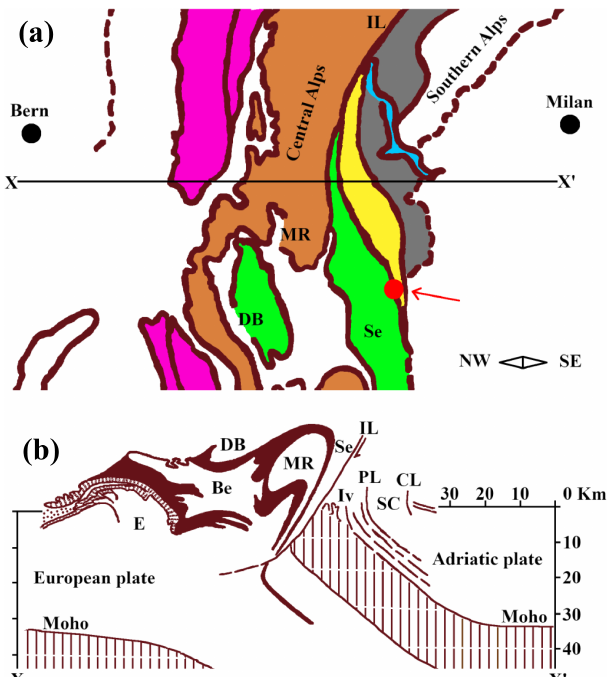
Figure 1. (a) Tectonic setting of the sample locality, digitally re- drawn and modified after Zingg (1990). The X – X (cid:48) line represents the profile section shown in panel (b) . In panel (a) , the purple area represents the external massifs, the light brown areas are the Pen- ninic basement, the green area shows the Austroalpine basement, and the orange area is the South Alpine basement. The yellow area is the Ivrea zone, and the light blue area is Lake Maggiore. Sample locality is indicated by the red dot and red arrow. (b) Cross-section through the Western Alps, digitally re-drawn after Zingg